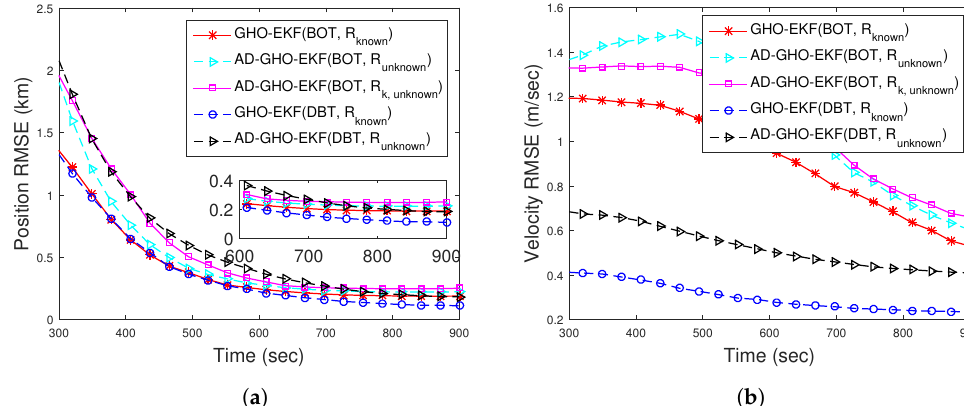
Figure 5. RMSEs of the BOT and DBT for Scenario I for unknown R .